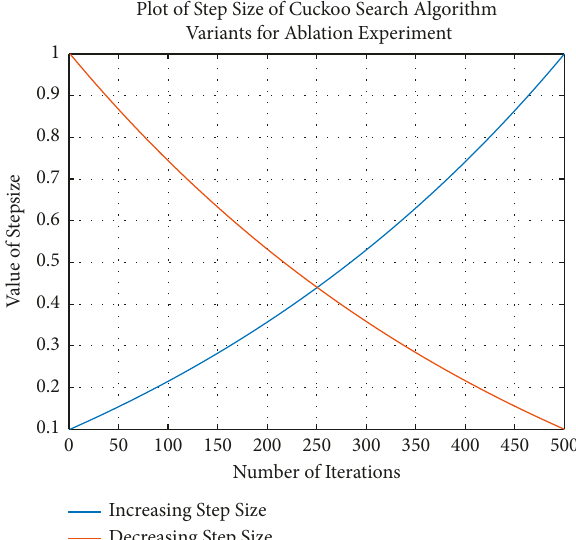
Figure 4: Plot of step size for cuckoo search algorithm variants for the ablation experiment.